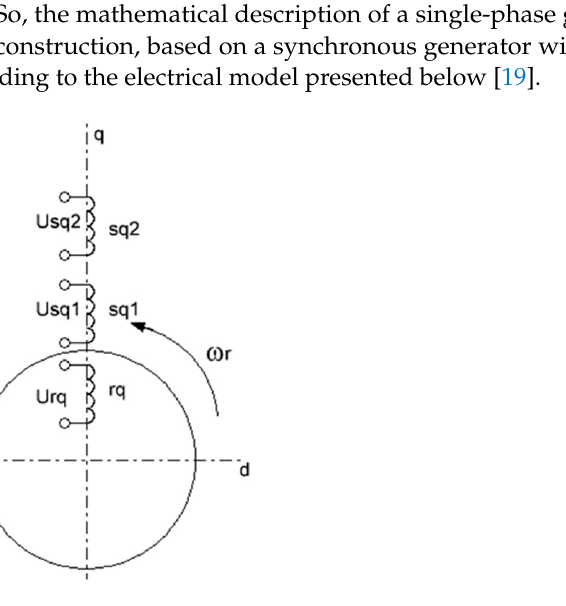
Figure 5. Electric circuit of a single-phase generator with a simplified